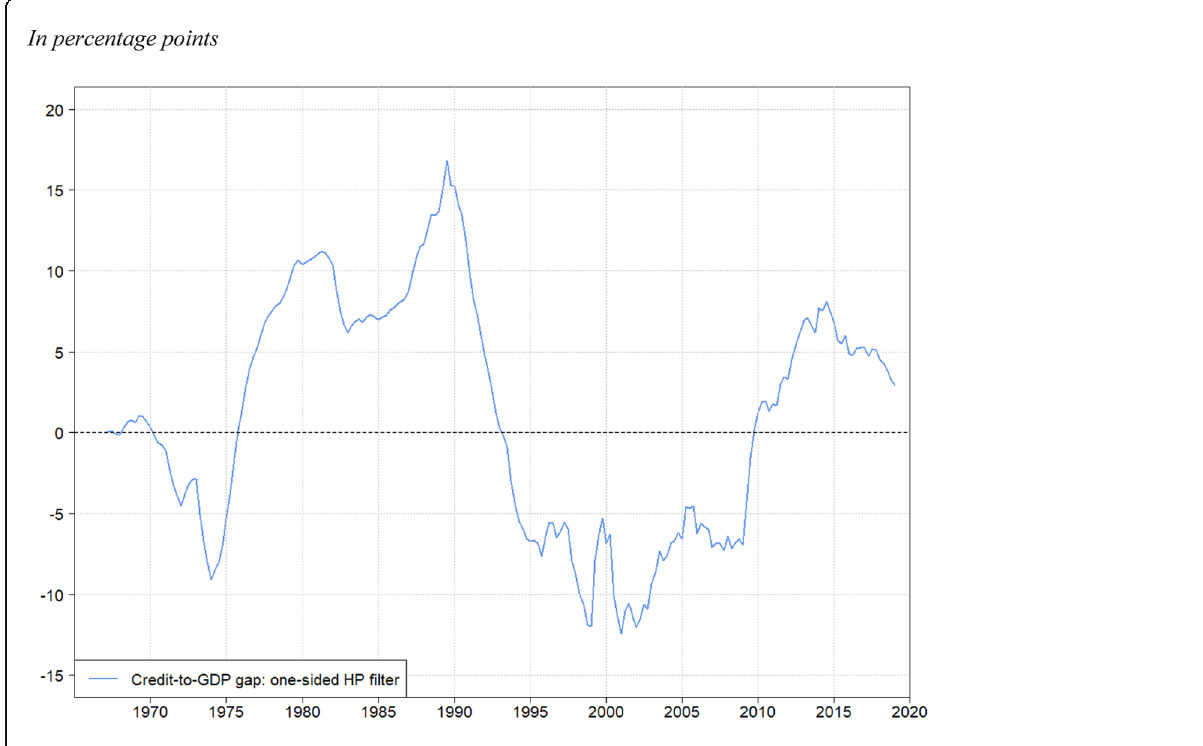
Fig. 2 The Swiss credit-to-GDP gap. In percentage